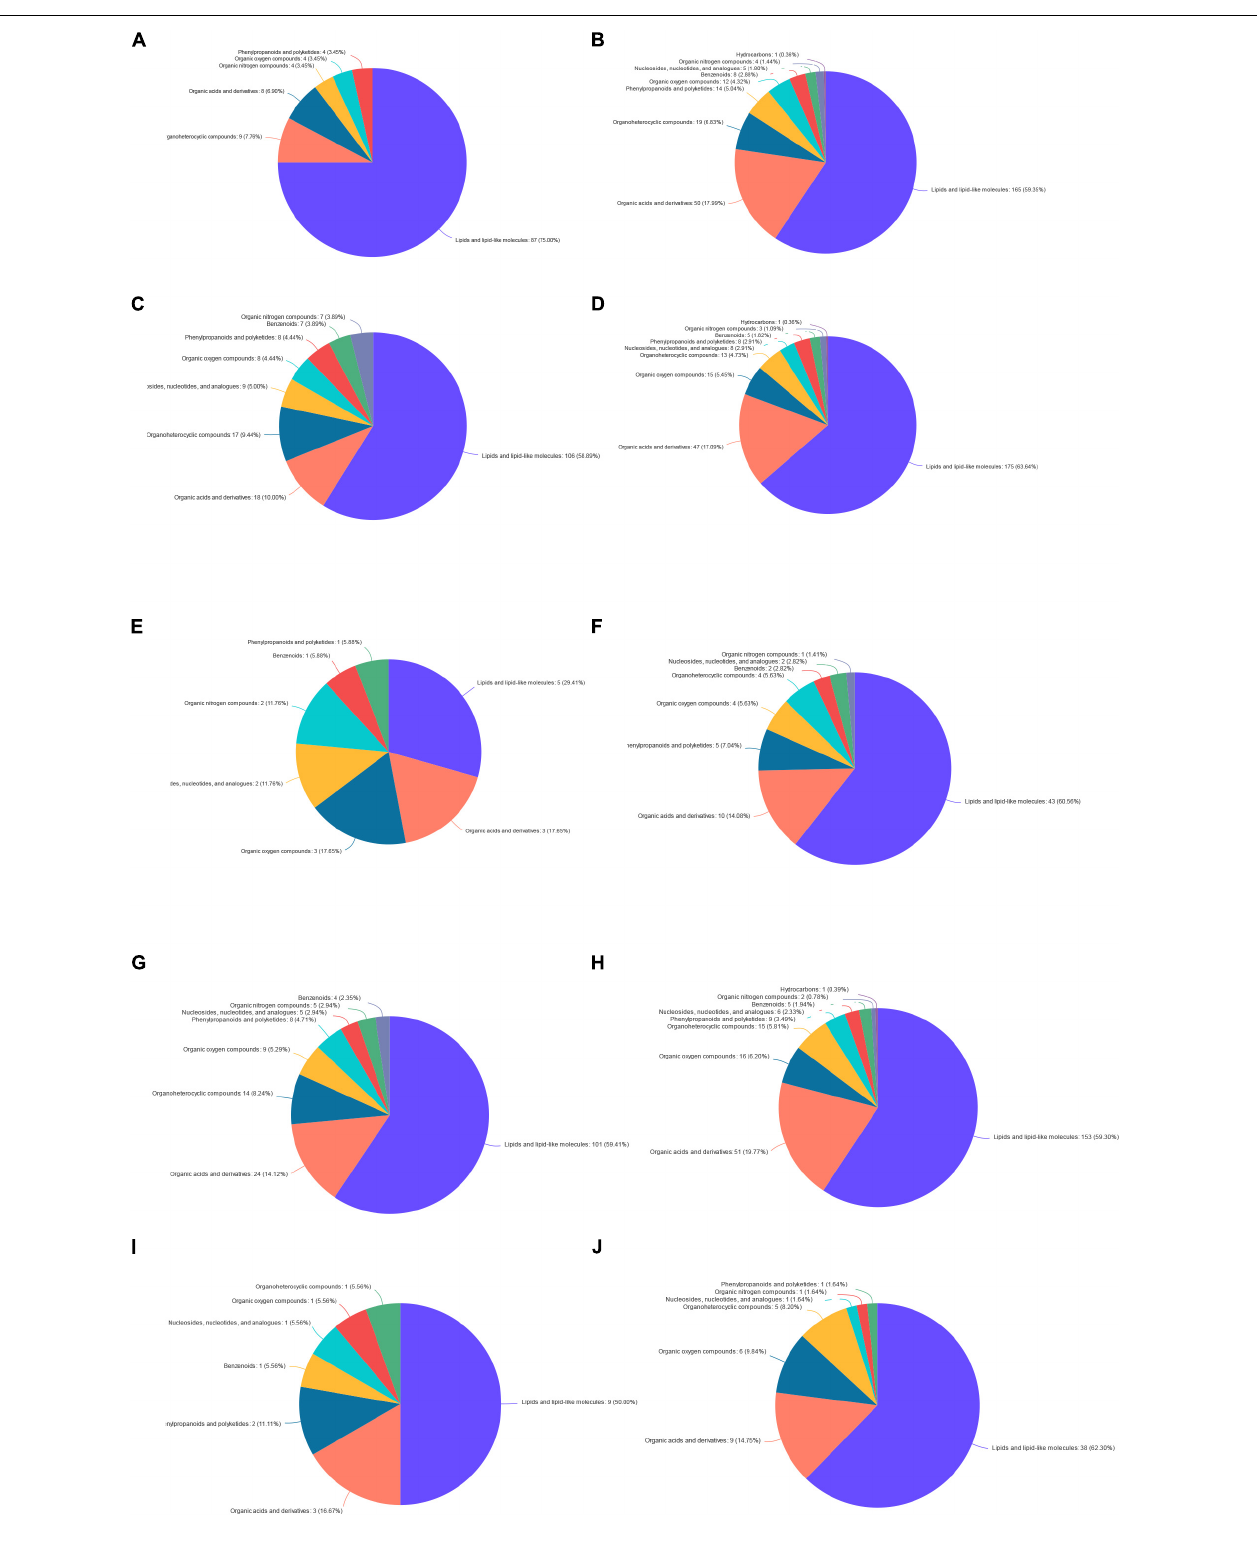
FIGURE 7 | The pie chart. Panel (A) for Dou vs. Con on 7th day; panel (B) for Dou vs. Con on 59th day; panel (C) for Met vs. Con on 7th day; panel (D) for Met vs. Con on 59th day; panel (E) for Met vs. Dou on 7th day; panel (F) for Met vs. Dou on 59th day; panel (G) for c-Com vs. Con on 7th day; panel (H) for c-Com vs. Con on 59th day; panel (I) for c-Com vs. Dou on 7th day; panel (J) for c-Com vs. Dou on 59th